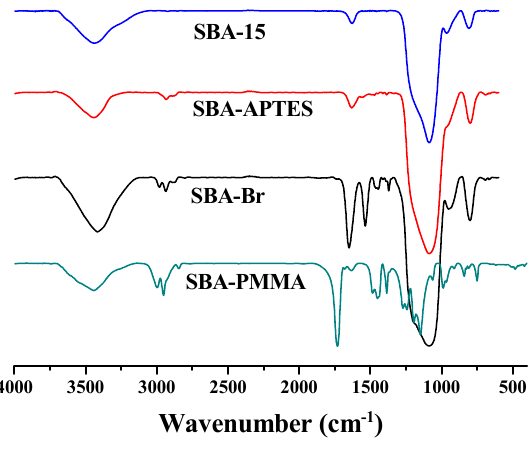
Figure 1. FT-IR spectra of SBA-15, SBA-APTES, SBA-Br, and SBA-PMMA.